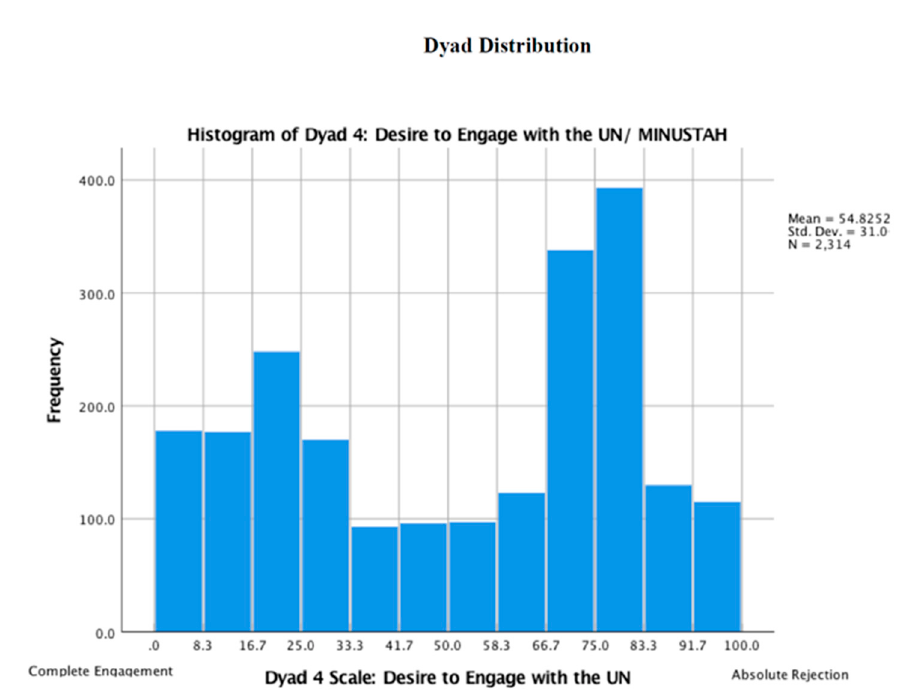
Figure A3. Distribution of Participant Responses to Dyad 4 (Desire to Engage with the UN/MI- NUSTAH).